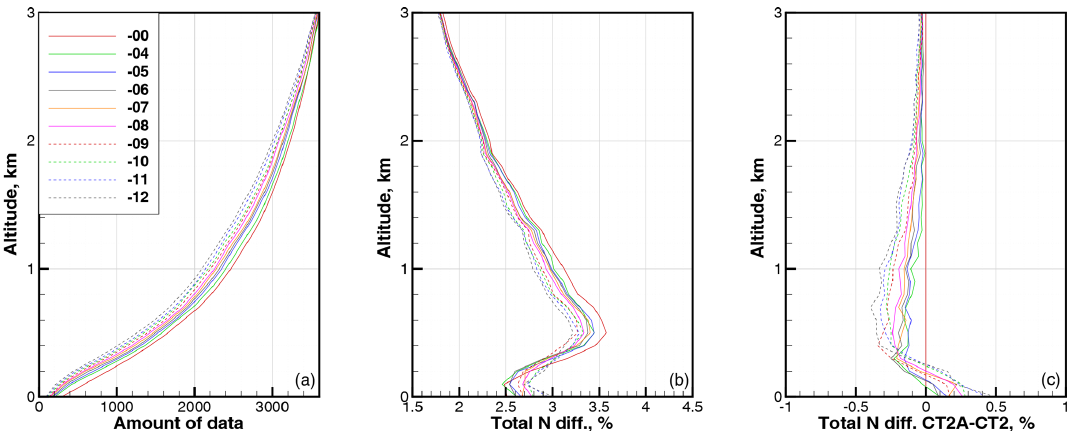
Figure 4. Statistics for latitude band 10–20 ◦ . (a) Amount of data. (b) RMS relative difference in refractivity COSMIC–ECMWF (cid:49)N CE . (c) RMS relative difference in refractivity CT2A–CT2. All are functions of the parameter β